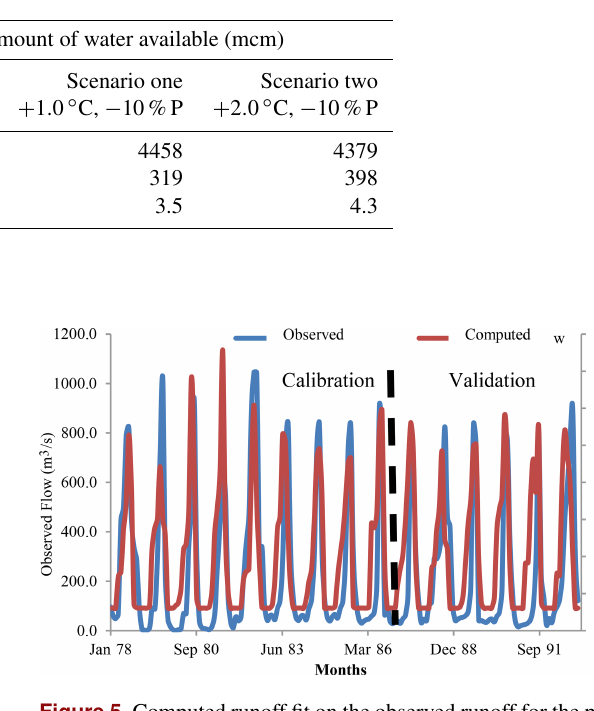
Table 3. Different climate warming impact on scenarios to water availability based on simulation of the sources for Gurara River.